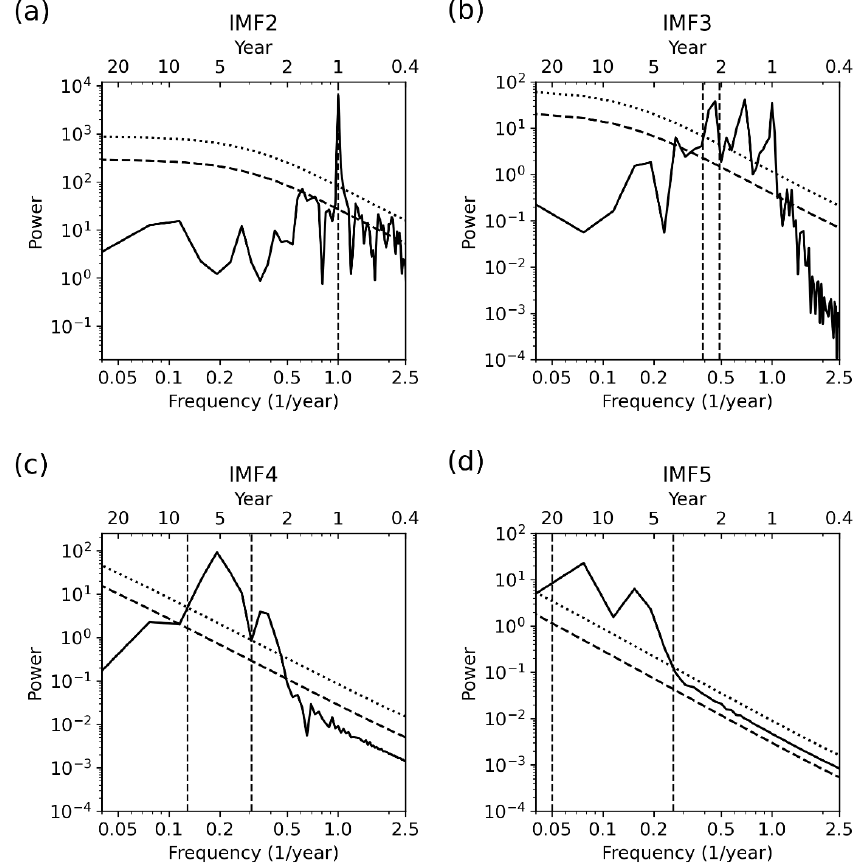
Figure 12. Power spectra of IMF2 ( a ), IMF3 ( b ), IMF4 ( c ), and IMF5 ( d ). Thick dashed lines indicate the best fit based on a first-order autoregressive model and the dotted lines indicate the 95% confidence level. The details of the power spectra and their significance tests can be seen in [59]. The dashed vertical lines show the time periods of high power, all of which pass the 95% significance test.